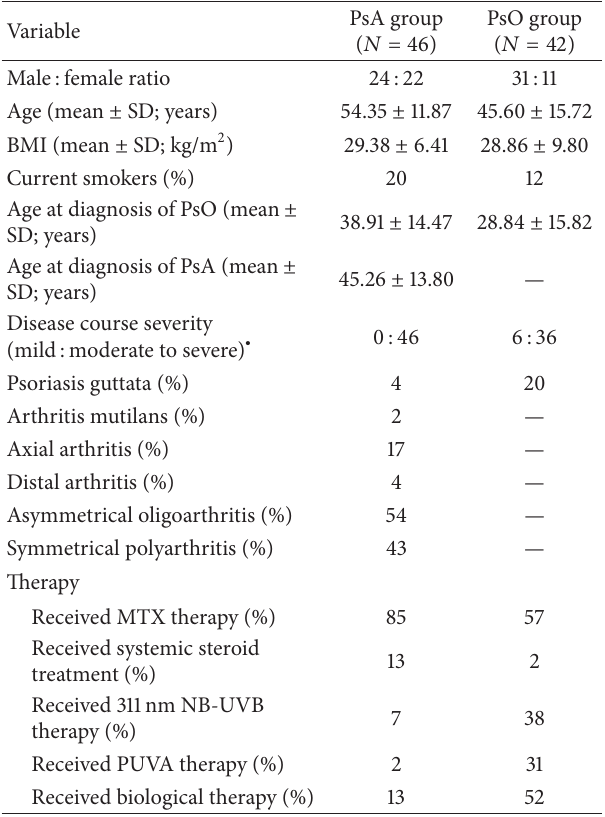
Table 1: Basic demographic and clinical characteristics of psoriatic arthritis (PsA) and psoriasis (PsO)